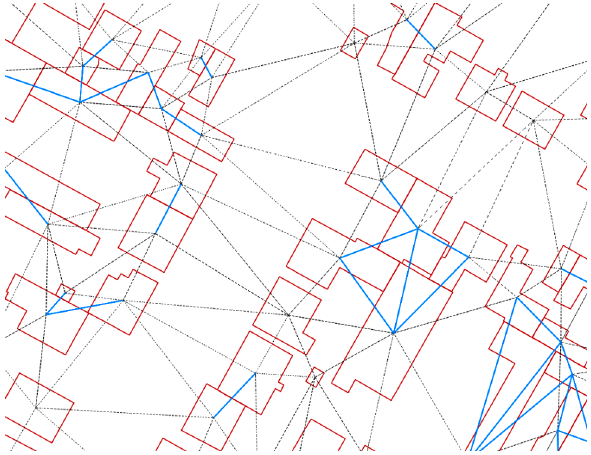
Figure 4: Metrics and topology constraints are enforced on both Delaunay triangulation network T (dashed line) and network T (cid:48) (blue line), respectively. Buildings are depicted in